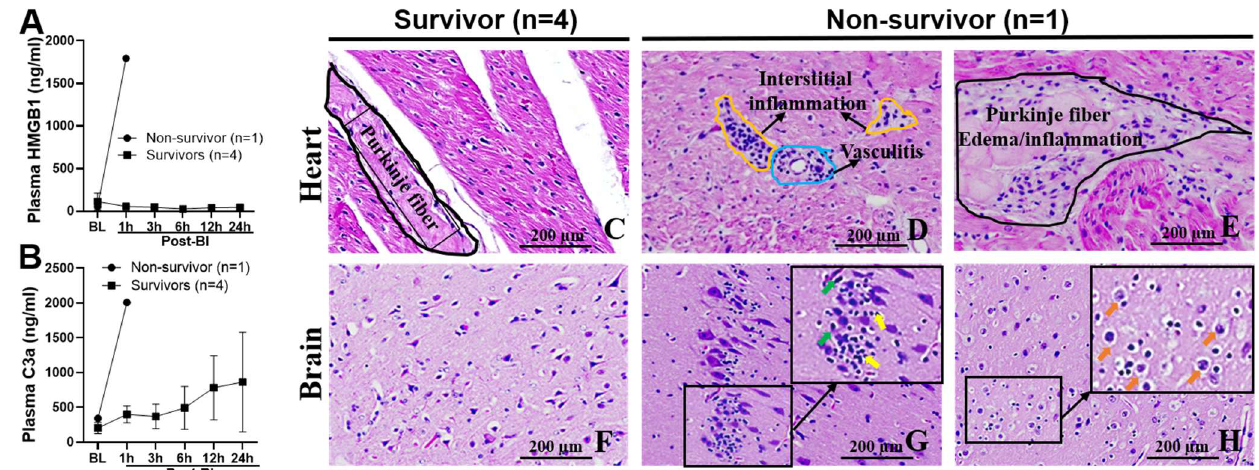
Figure 5. Parallelism of the blood plasma levels of HMGB1 ( A ) and C3a ( B ) without myocarditis ( C ) and neuroinflammation ( F ), and with myocarditis ( D ), Purkinje fiber edema/inflammation ( E ), neuroinflammation ( G , yellow arrows)/neuronal death ( G , green arrows), and cytotoxic brain edema ( H , orange arrows) in a porcine BI+HS model. The data were expressed as mean ± SD.